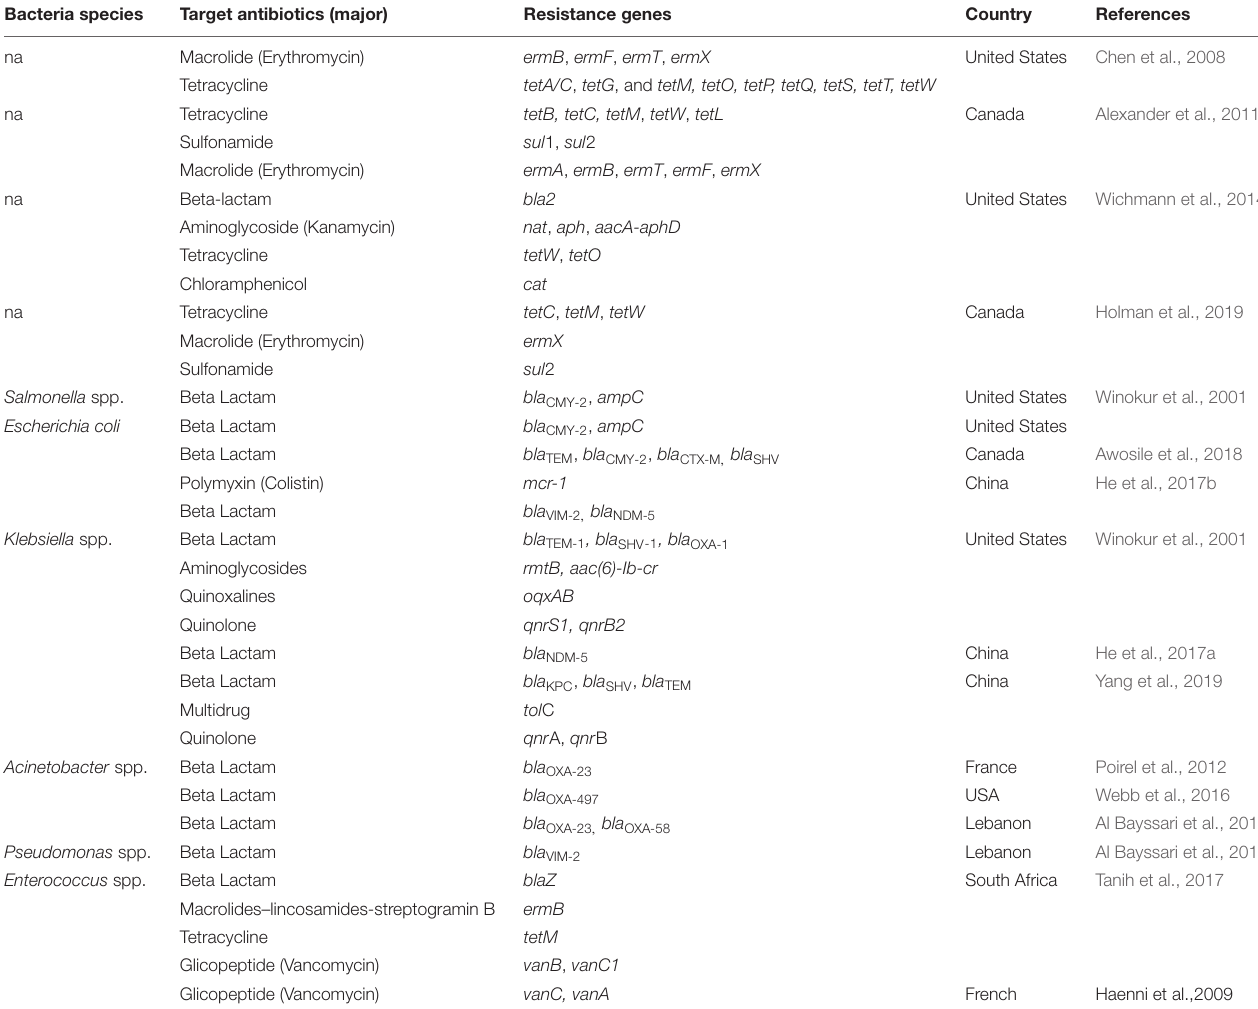
TABLE 2 | Antibiotic-resistant bacteria and antibiotic resistance genes in cow